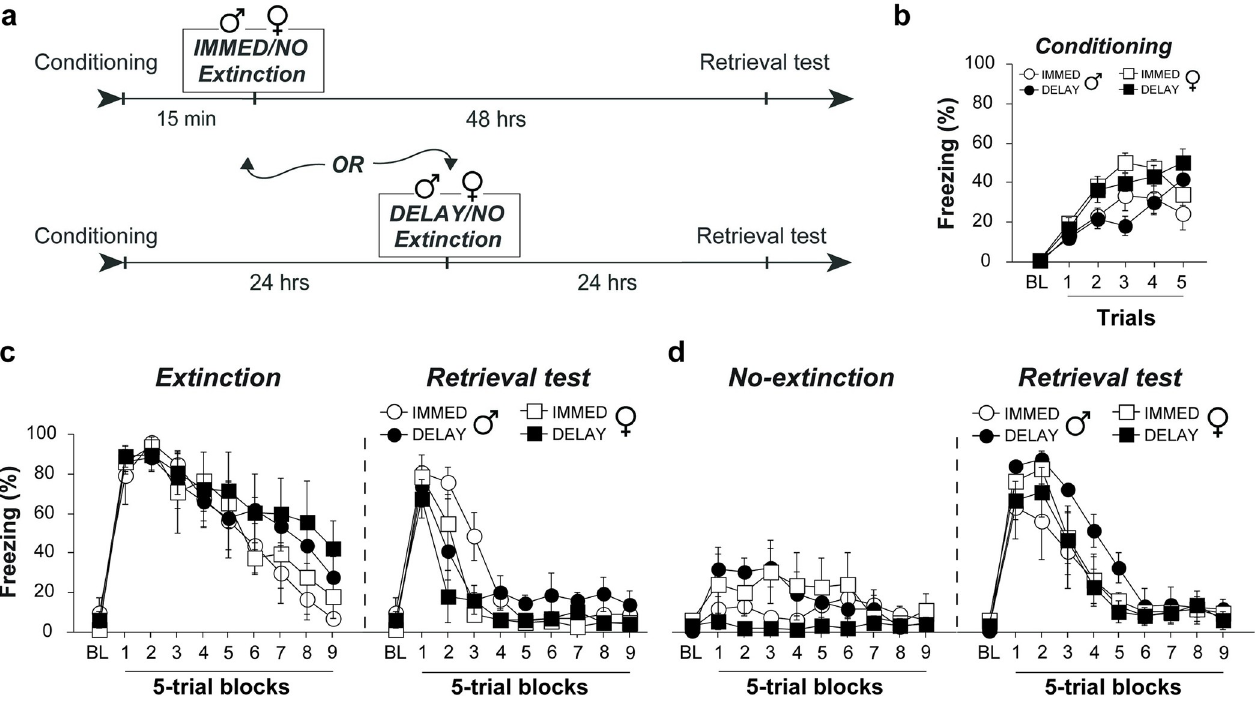
Fig 2. Male ( ) and female ( ) Wistar rats exhibit an IED. (A) Behavioral timeline for the different experimental groups. (B) All groups acquired similar levels of conditioned freezing prior to extinction. (C) Wistar rats that underwent extinction training showed a reduction in fear across extinction trials with immediately extinguished rats reaching lower levels of freezing than delayed animals. Despite this, immediate extinction animals still showed impaired extinction during retrieval testing as indicated by reduced rate of re-extinction. This effect was similar in both males and females. (D) Comparatively, No- Extinction animals exhibited high levels of conditioned freezing during retrieval testing that was similar among all groups. All error bars represent ±